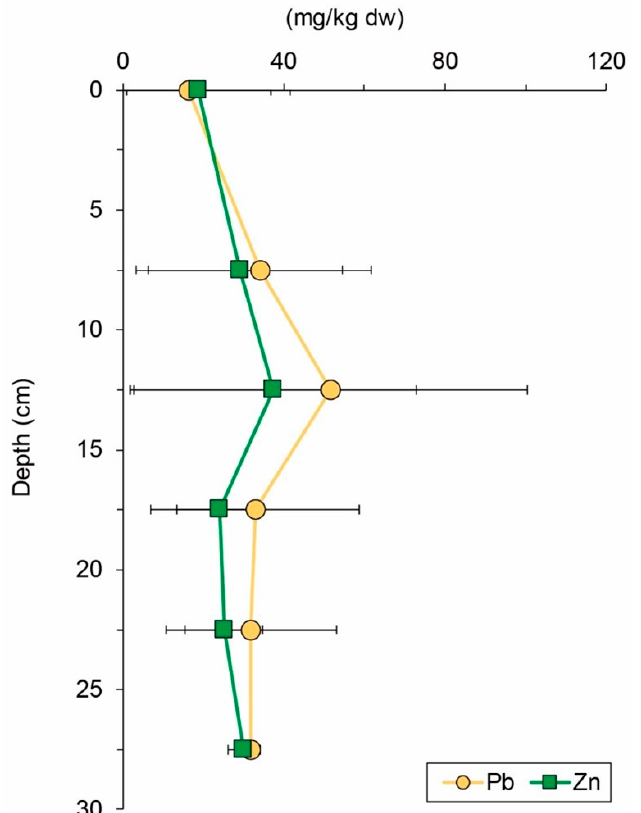
Figure 3. Depth profiles of Pb (circles) and Zn (squares). Mean values ( ± SD) in sediments from P é trola Lake ( n =